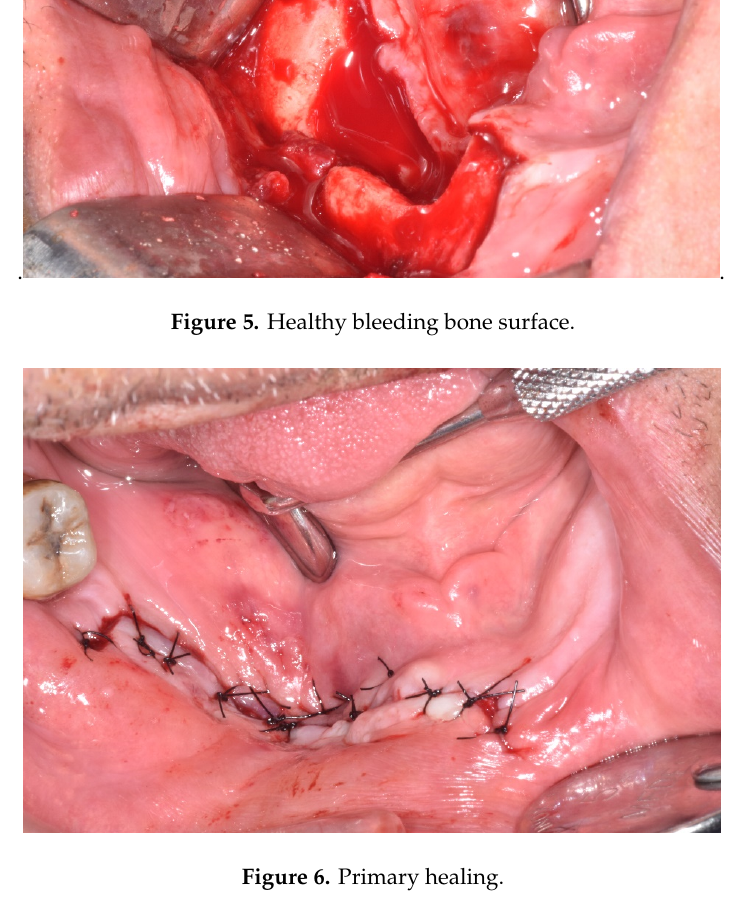
Int. J. Environ. Res. Public Health 2020 , 17 , x FOR PEER REVIEW